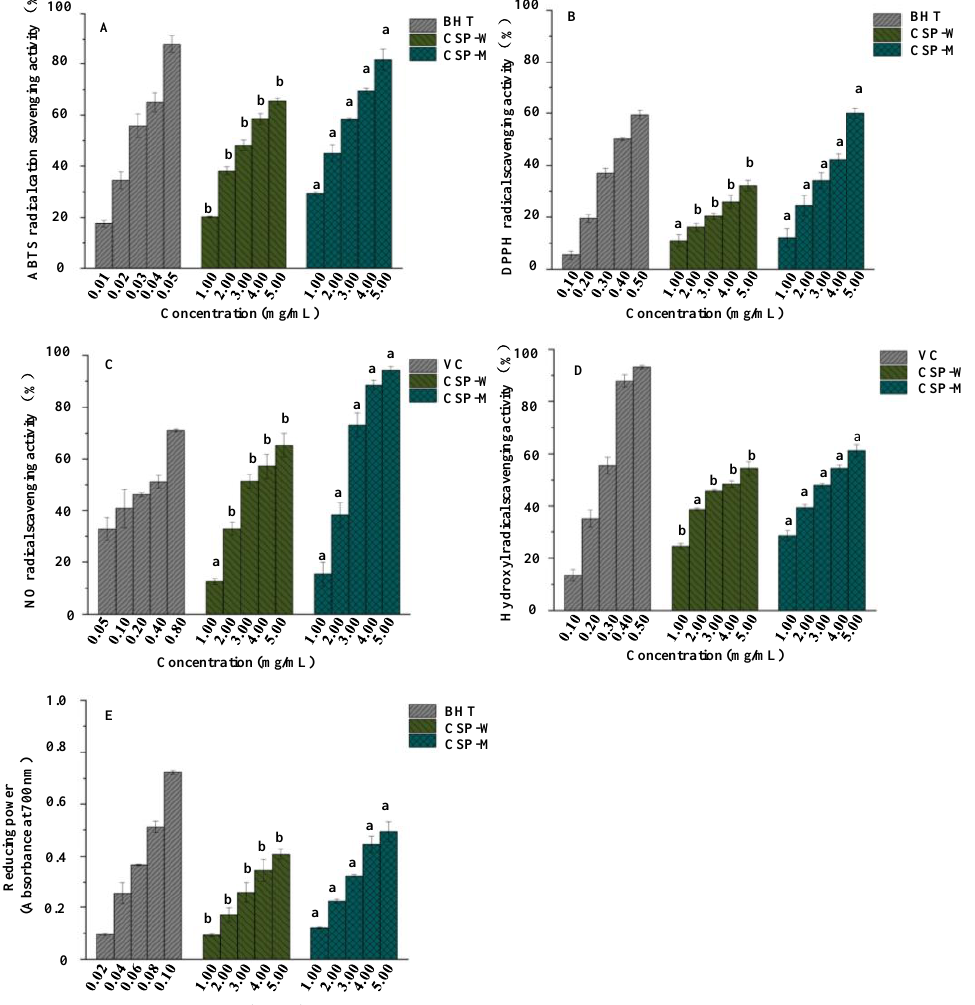
Figure 5. ABTS ( A ), DPPH ( B ), nitric oxide ( C ), and hydroxyl ( D ) radical scavenging activities, and reducing powers ( E ) of CSP-W and CSP-M. CSP-W , Cassia seed polysaccharides extracted by hot water extraction; CSP-M , Cassia seed polysaccharides extracted by microwave-assisted extraction; The error bars are standard deviations; significant ( p < 0.05 ) differences between CSP-W and CSP-M at the same concentration are shown by data bearing different letters (a,b); statistical significances were carried out by an independent sample t -test.